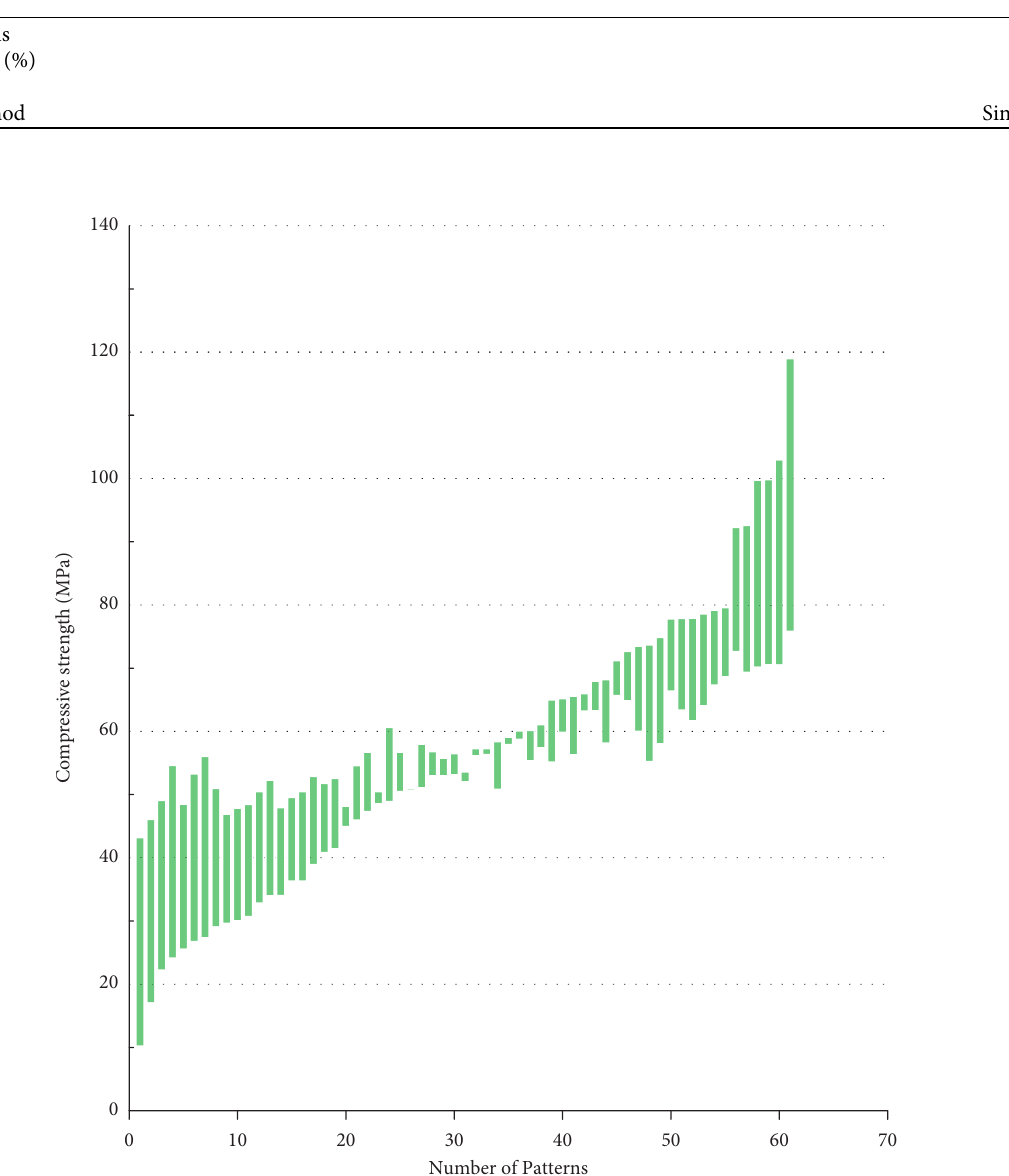
Figure 10: Floating bar chart of errors of ANN-GA (7-13) model using testing